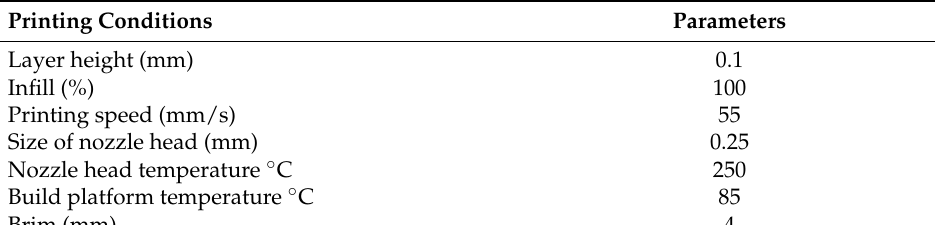
Table 5. Three-dimensional printing parameters.